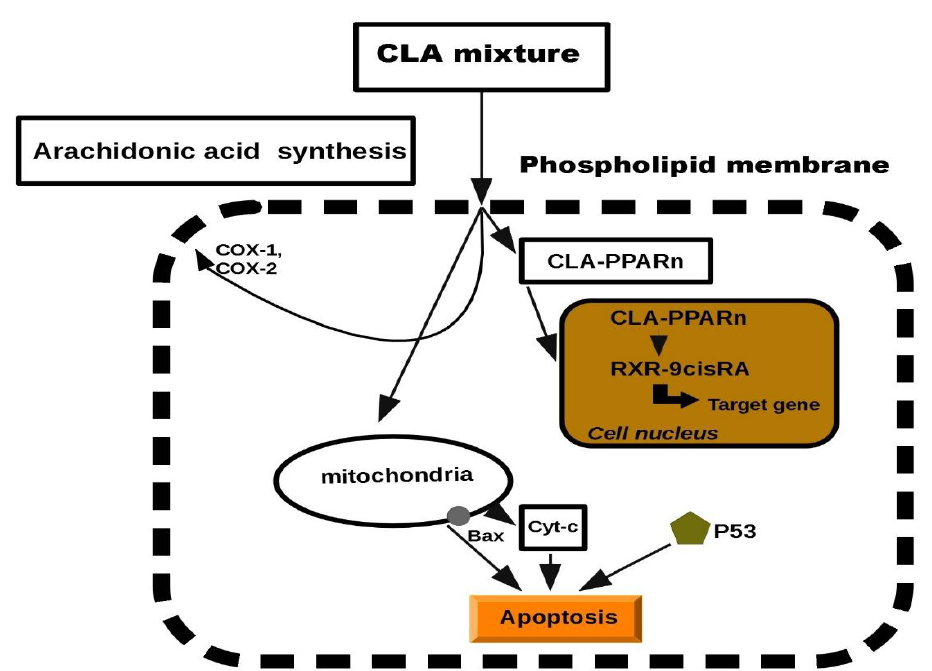
Figure 2. Schematic model of cell apoptosis induced by CLA.